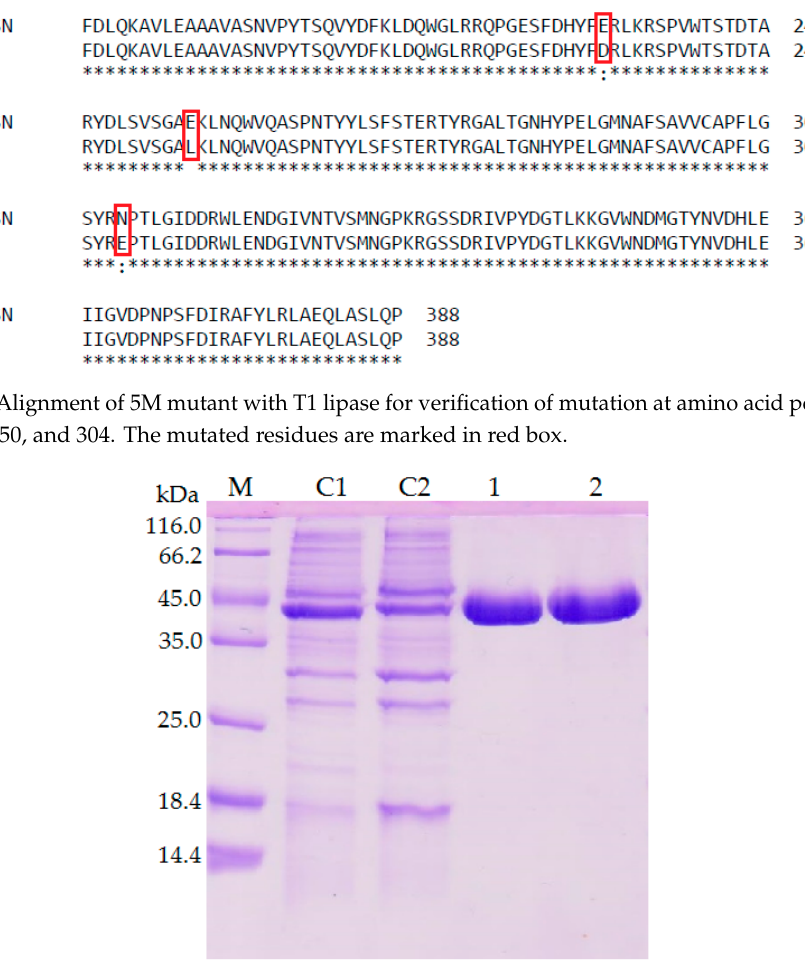
Figure 2. SDS-PAGE analysis of the wt-HT1 and 5M mutant lipases. The concentration of each samples (crude and purified enzymes) were standardized to 100 µg. Lane M; Molecular weight marker. Lane C1; crude enzyme of wt-HT1 lipase. Lane C2; crude enzyme of 5M mutant lipase. Lane 1; purified wt-HT1 lipase. Lane 2; purified 5M mutant lipase.